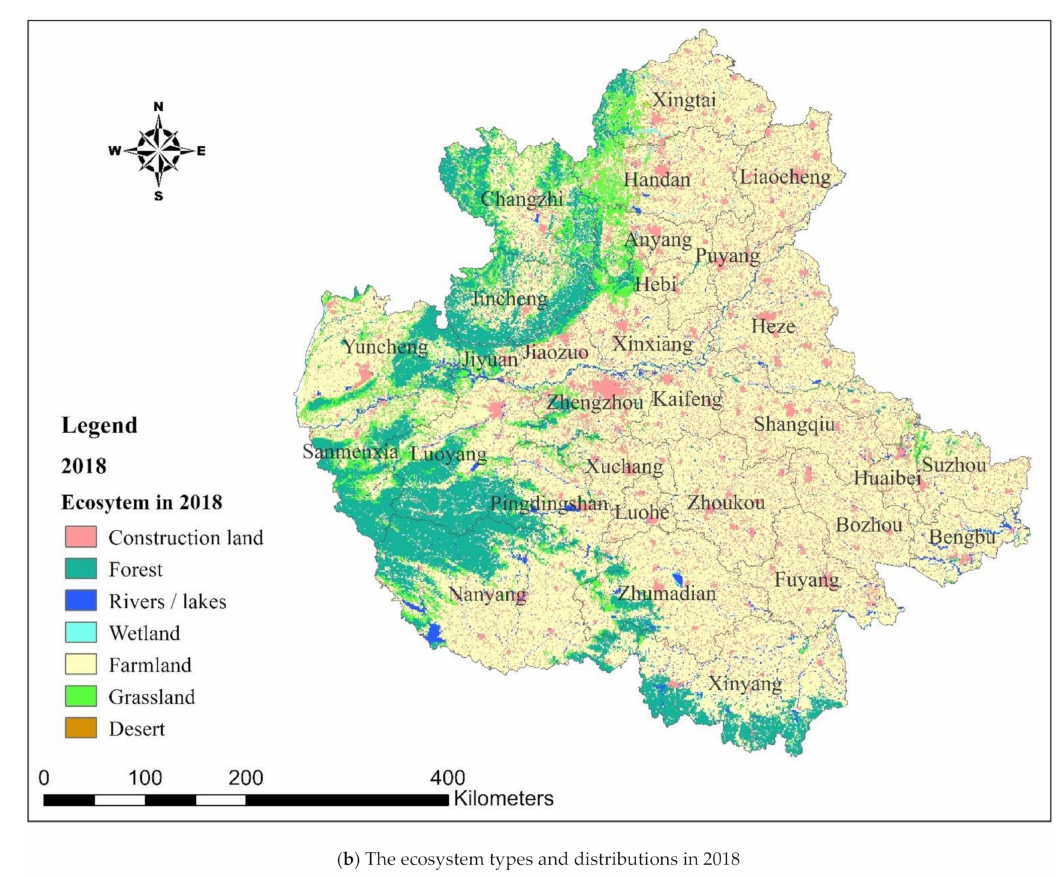
Figure 2. The ecosystem types and distributions obtained from the land use data of the Central Plains Urban Agglomeration in 2000 and 2018. Table 2. ESV equivalent table per unit area of terrestrial ecosystem in China [40,41]. Forest Grassland Farmland Wetland Rivers/Lakes Desert